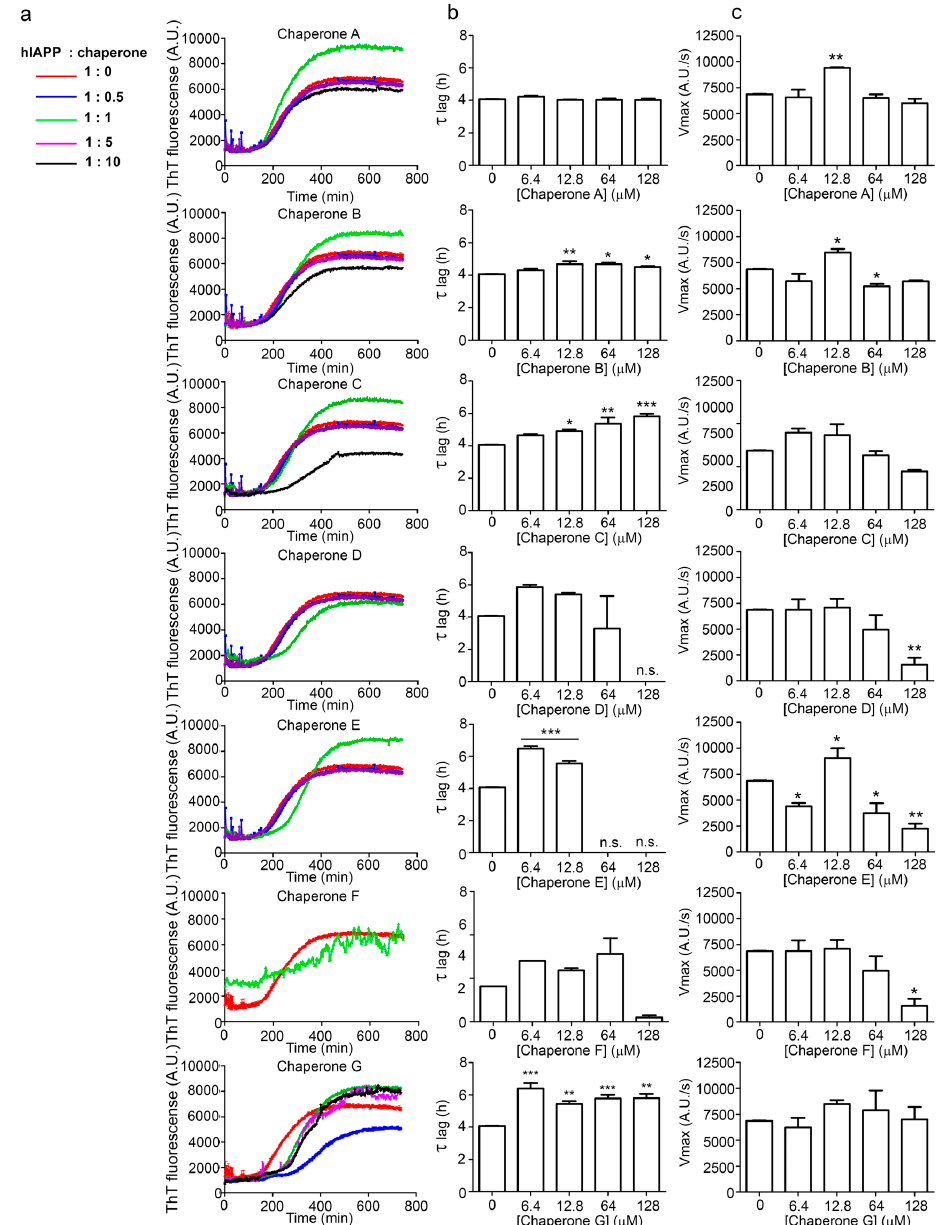
Figure 6. Kinetics, ν max and τ lag in hIAPP 1–37 aggregation with the chaperones A , B , C , D , E , F and G . The experiments were conducted in 20 mM Tris-HCl, 100 mM NaCl (pH 7.5) at 37 °C. In all the conditions the chaperones were incubated with hIAPP 1–37 (12.8 µmol/L). ( a ) We incubated the chaperones at different molar relations. Blue line 1:05 (12.8 µmol/L:6.4 µmol/L), green line 1:1 (12.8 µmol/L:12.8µmol/L), purple line (12.8 µmol/L:64 µmol/L), and black line (12.8 µmol/L:128 µmol/L), using the oligomers of hIAPP 1–37 (red line) as the control (12.8µmol/L); ( b ) Phase lag ( τ lag) in hIAPP 1–37 aggregation and fibril formation reached by the chaperones A , B , C , D , E , F and G ; ( c ) Vmax in hIAPP 1–37 aggregation and fibril formation reached by the chaperones A , B , C , D , E , F and G . * p < 0.05, ** p < 0.01, *** p < 0.001 when compared with hIAPP 1–37 condition only as control. One-way ANOVA and post-hoc Newman–Keuls Multiple Comparison Test. n.s. = data not shown.